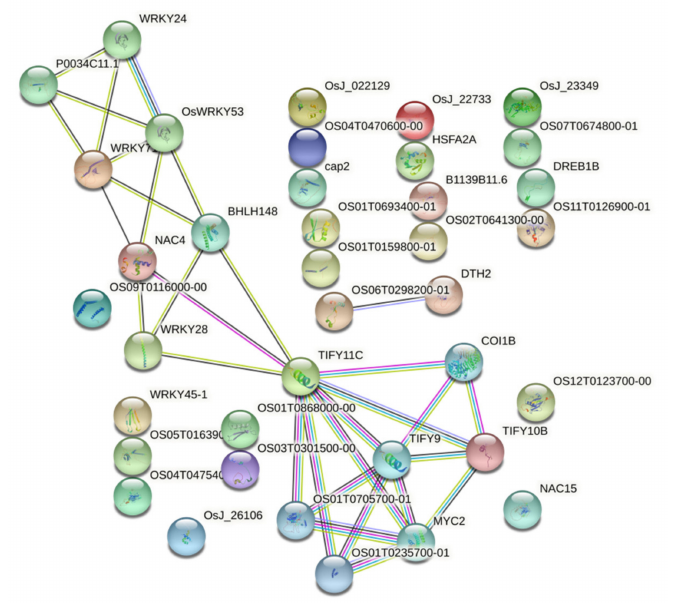
Figure 5. The protein–protein interaction network of the transcription factor genes coding proteins analyzed by STRING software. The color-coded transcription factor proteins are represented by nodes. Different colored lines represent co-expression evidence between proteins. Red line: gene fusion evidence; dark blue line: co-occurrence evidence; black line: co-expression evidence; yellow line: text-mining evidence; green line: neighborhood genome evidence; light-blue line: database evidence; and pink line: experimental evidence.